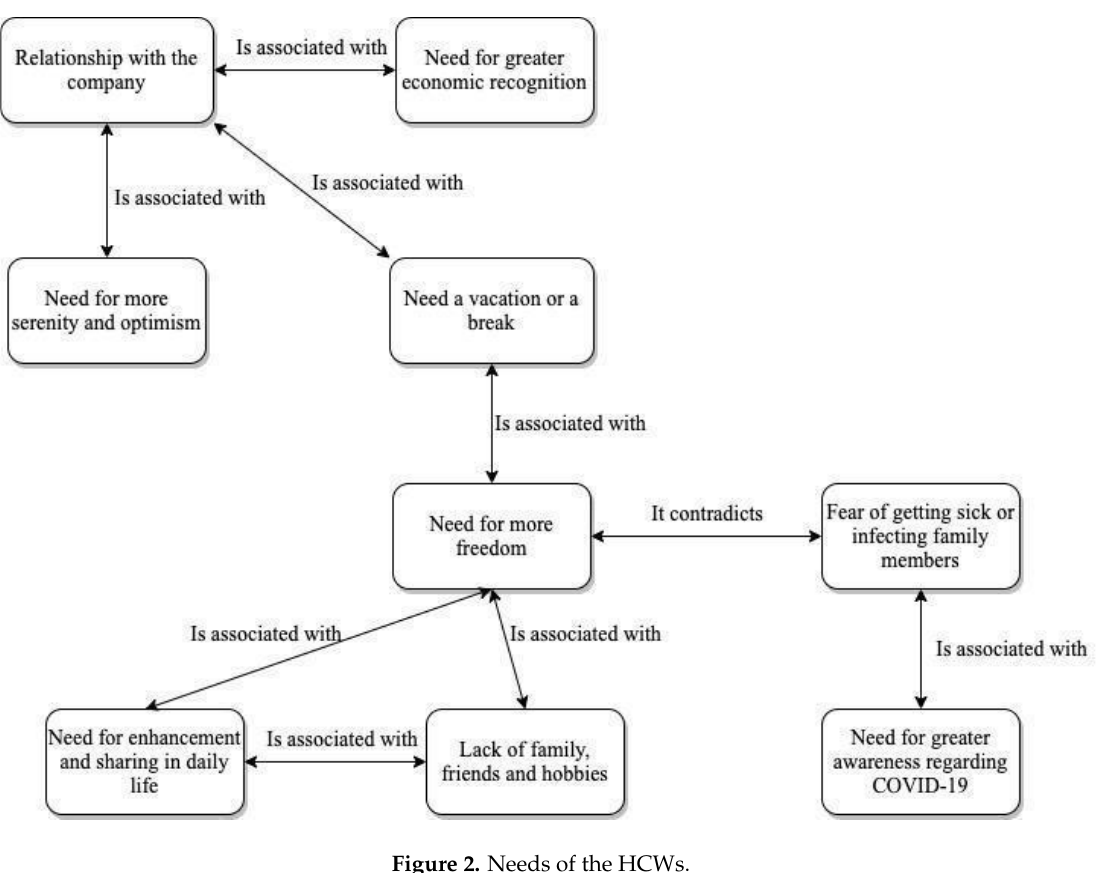
Figure 2. Needs of the